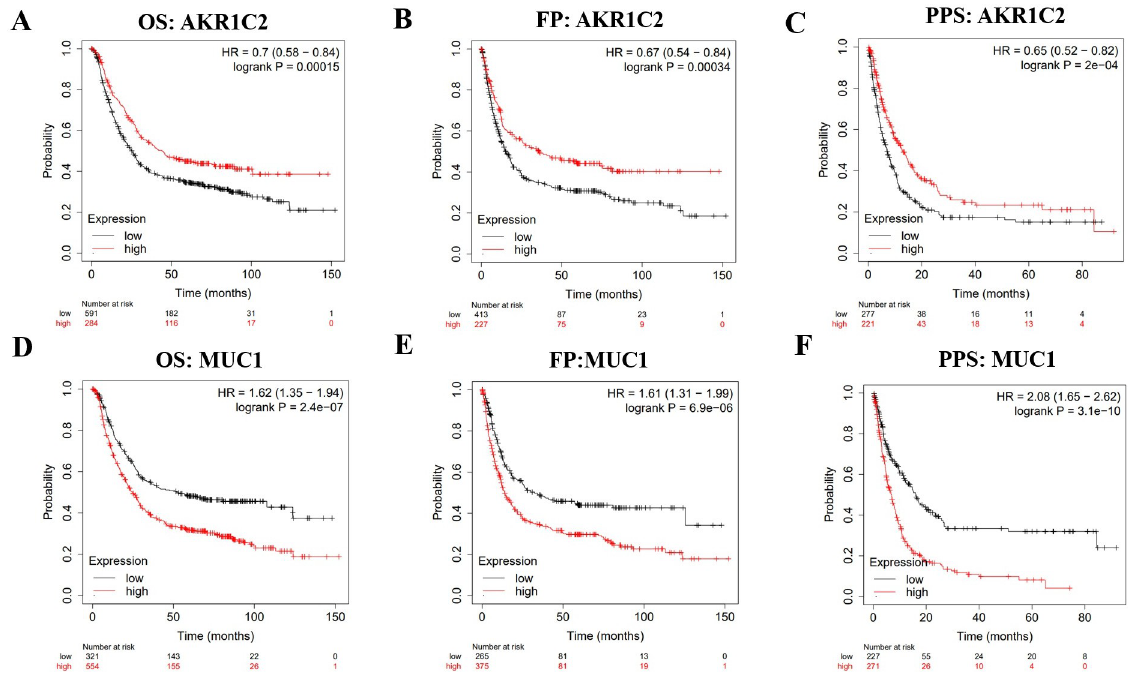
Fig 2. Kaplan-Meier Plotter depicting the prognostic values of AKR1C2 and MUC1 in gastric cancer. (A-C) The prognostic values of AKR1C2 in GC patients. (D-F) The prognostic values of MUC1 in GC patients. OS: overall survival, FP: first-progression, PPS: post progression